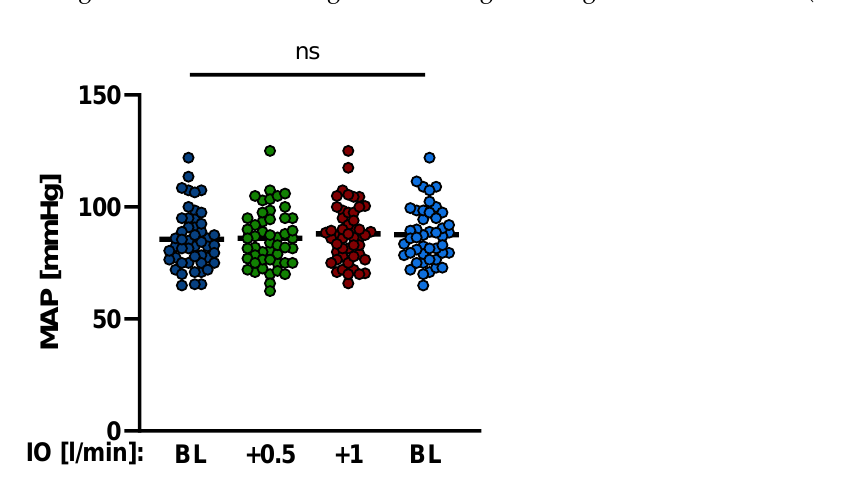
Table 2. Parameters of invasive hemodynamic measurement on different levels of Impella ® support. MAP: mean arterial pressure; SAP: systolic arterial pressure; DAP: diastolic arterial pressure; RRI: renal resistive index; CI: cardiac index; CO: cardiac output; SVR: systemic vascular resistance; cvsO 2 : central venous oxygen saturation.